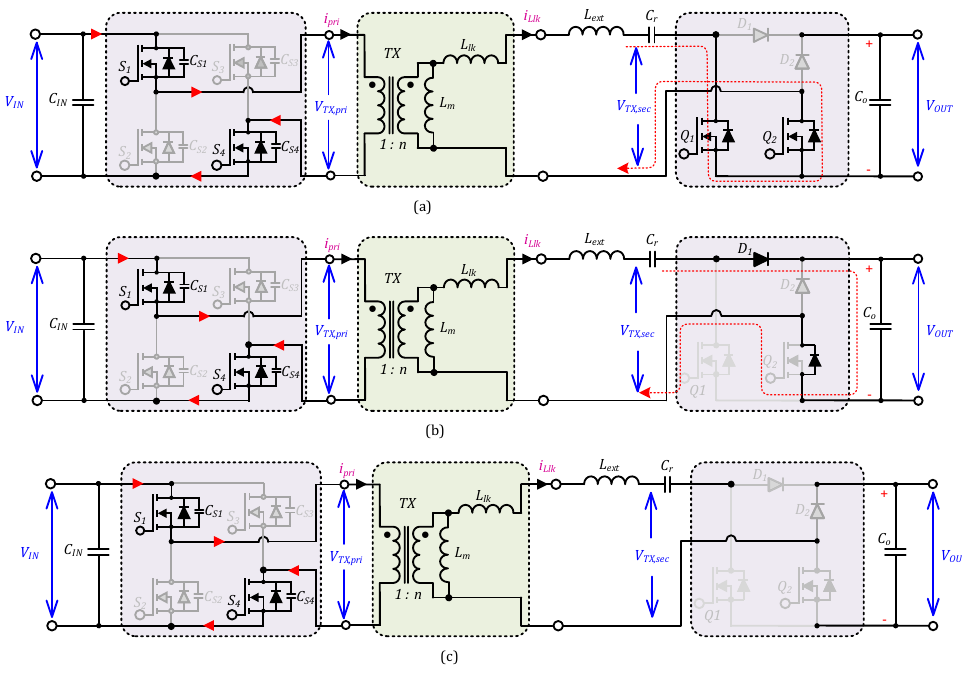
Figure 8. Operating modes of the converter during a one-half cycle with the short-pulse modulation: ( a ) Mode I; ( b ) Mode II; ( c ) Mode III.